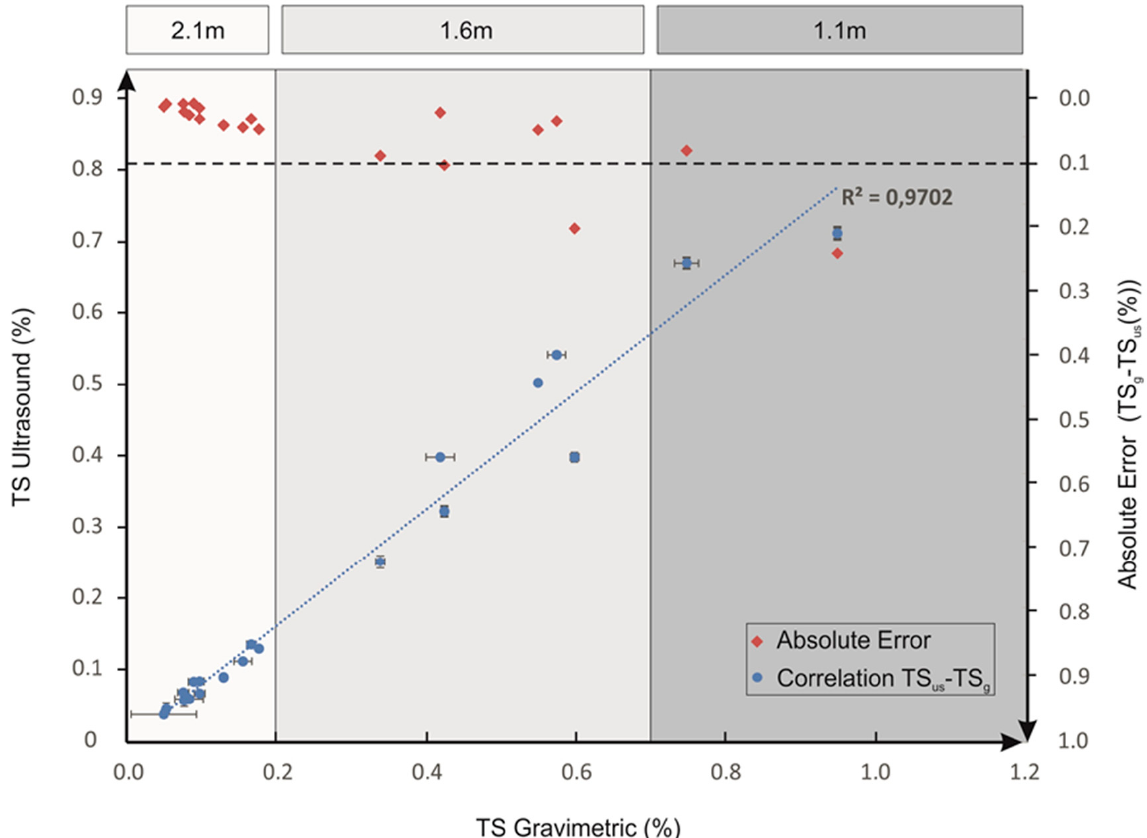
Figure 5. Correlation between sensor signal and gravimetric analysis in different positions inside the UASB reactor obtained during the long performance tests. The circles represent the results obtained from the correlation between gravimetric values and sensor values (converted to TS concentration). The diamonds are the absolute errors, calculated as the difference between the gravimetric values and the sensor values ( × 10 − 2 ) for each point. The error bars, shown in the correlation symbols (circles), are defined as the standard deviation of the sensor signals (vertical error bars) and the standard error calculated from the gravimetric analysis triplicates (horizontal error bars). The dashed line is to highlight absolute errors below (and above) 0.01%. The dotted line is a linear correlation curve.